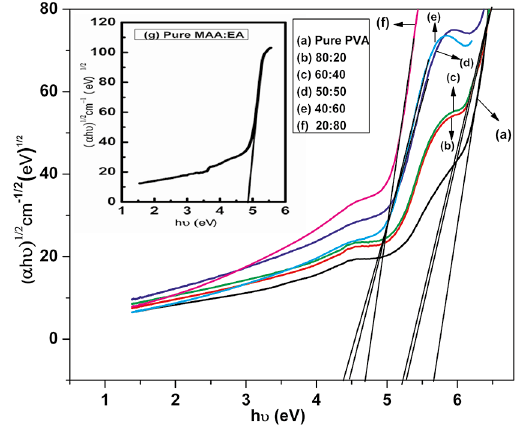
Figure 11. (αhυ) 1/2 vs hυ curves of pure and PVA/MAA:EA blend samples(a) Pure PVA (b) 80:20 (c) 60:40 (d) 50:50 (e) 40:60 (f)